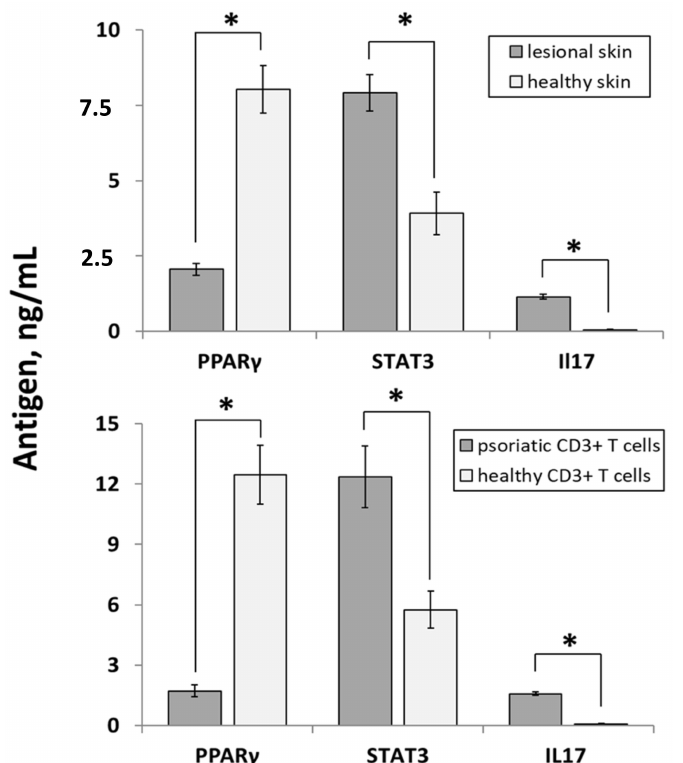
Figure 3. The expression levels of selected proteins in the samples obtained from psoriasis patients ( n = 23) and healthy volunteers ( n = 10) assessed by ELISA. The upper panel—lesional vs. healthy skin. The lower panel—samples of CD3 + T cells of psoriasis patients and healthy volunteers. Statistically significant changes in gene expression ( p < 0.05) are marked with asterisk sign